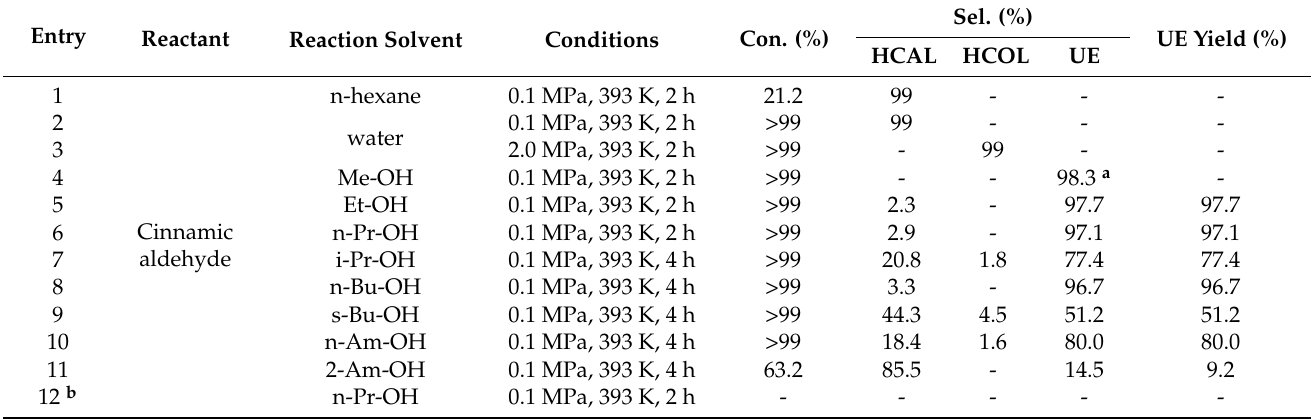
Table 3. Catalytic hydrogenation performance over (AlPO 4 ) 0.1 /Ni 2 P catalyst for cinnamic aldehyde with controlled reactants and reaction conditions. a : Diacetal; b : Performed under N 2 pressure (without H 2 ); HCAL: Phenylpropionaldehyde; HCOL: Phenylpropanol; UE: Unsaturated